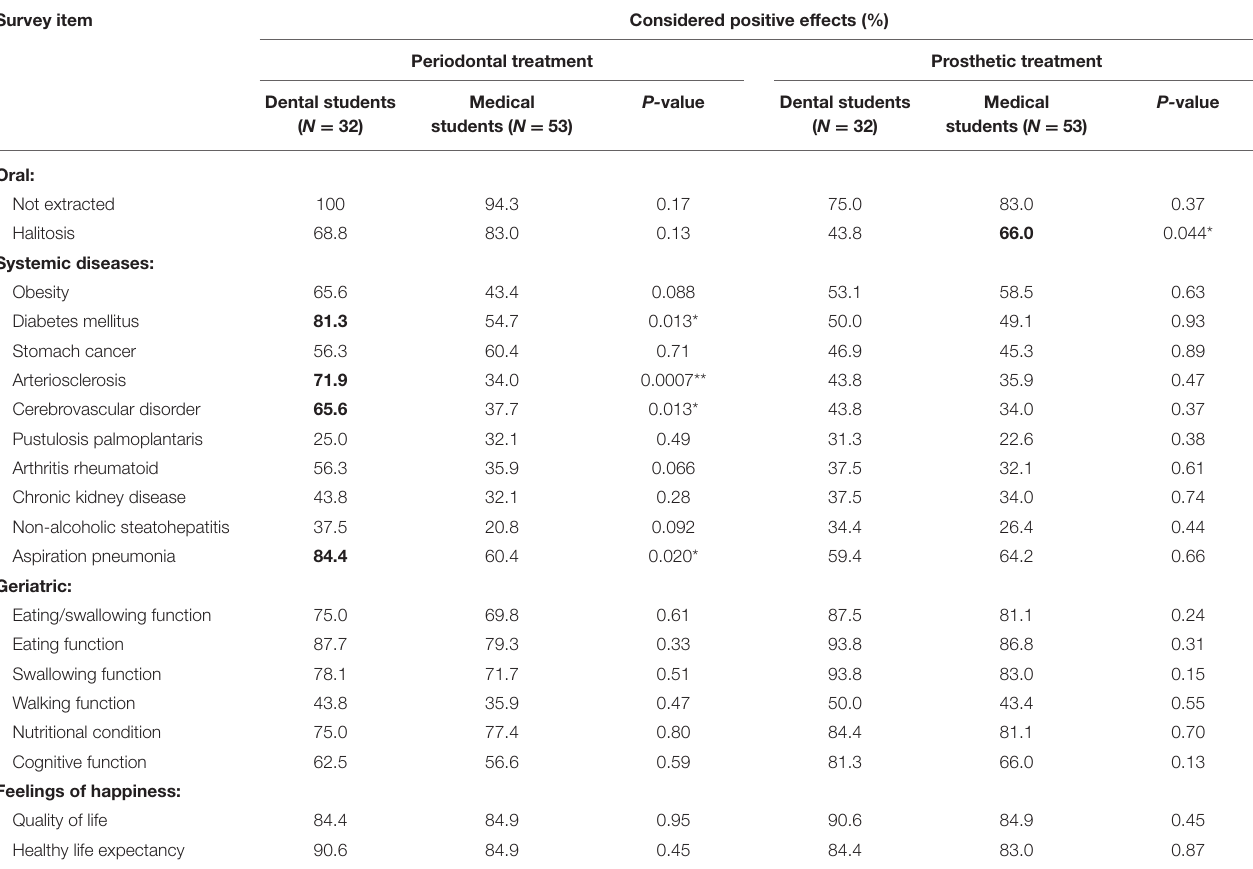
TABLE 1 | An awareness survey of dental and medical students before clinical training about the effects of periodontal or prosthetic treatment on diseases, symptoms, and conditions. Survey